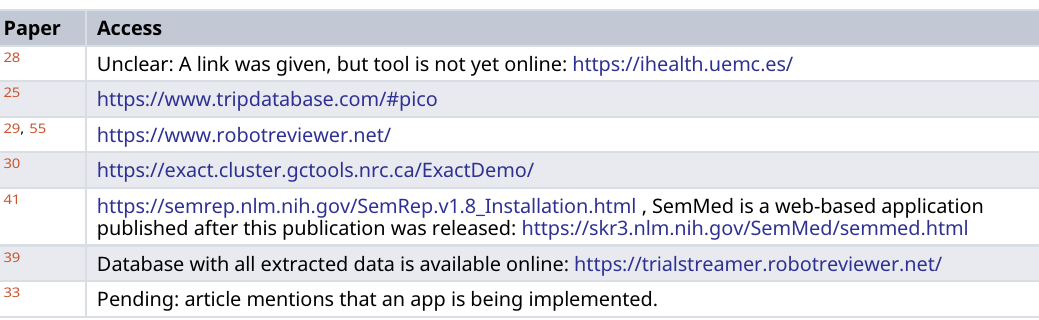
Table 3. Publications that provide user interfaces to their final data extraction system.